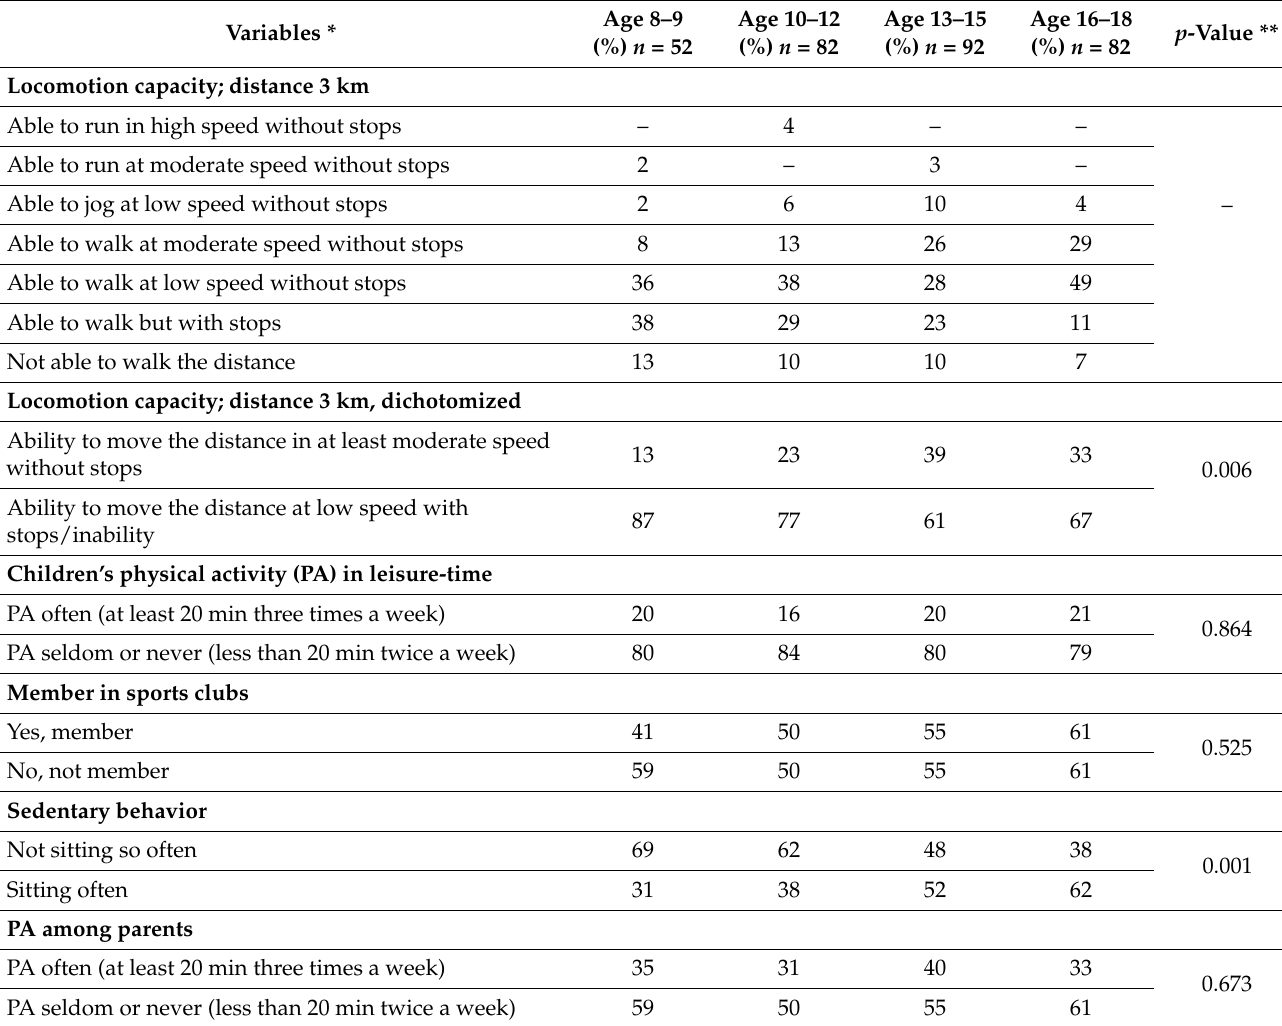
Table 4. Locomotion capacity, physical activity (PA) in leisure-time, membership in sports clubs, sedentary behavior and parents’ PA in relation to age groups among children with Down Syndrome (%).